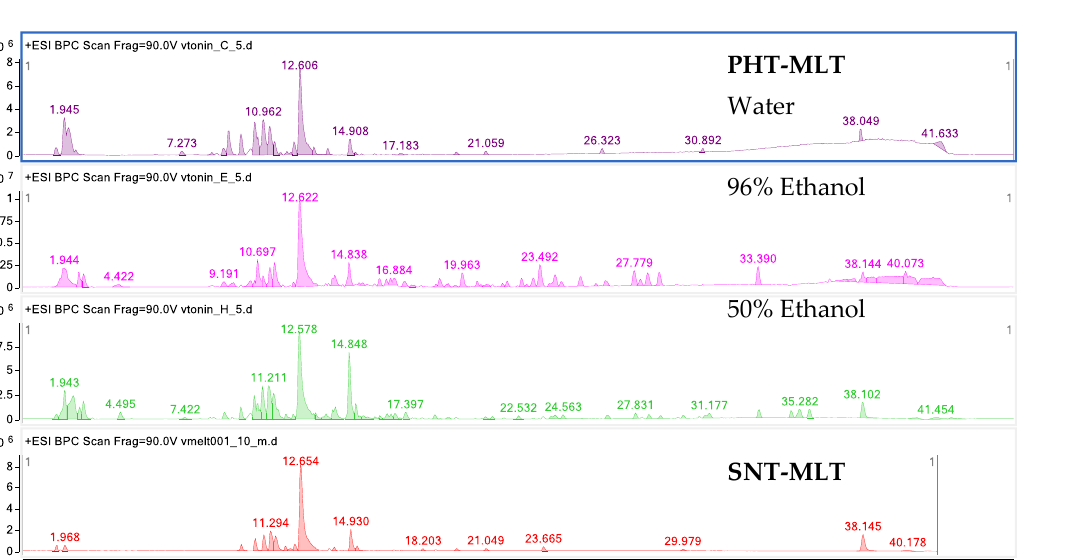
Table 1. The content of melatonin in the extracts from PHT-MLT powder calculated from the cor- responding mass chromatograms (SD — standard deviation). Type of Extract